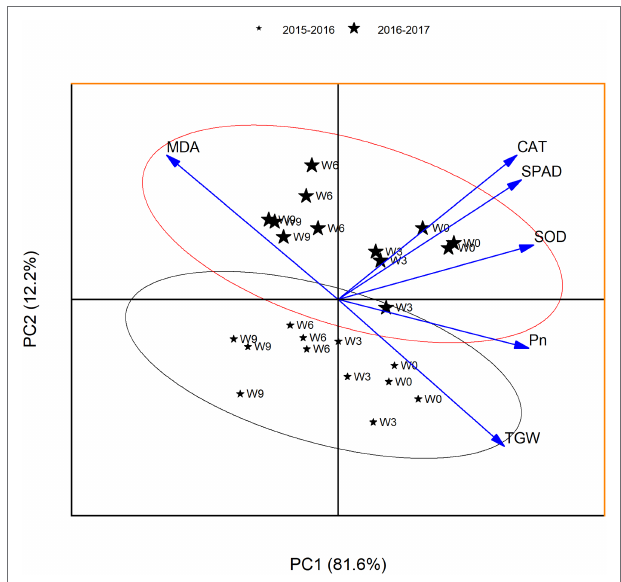
FIGURE 8 | PCA for the yield-related traits at 21 DAA. W0 = control, W3 = 3 days of waterlogging, W6 = 6 days of waterlogging, W9 = 9 days of waterlogging.